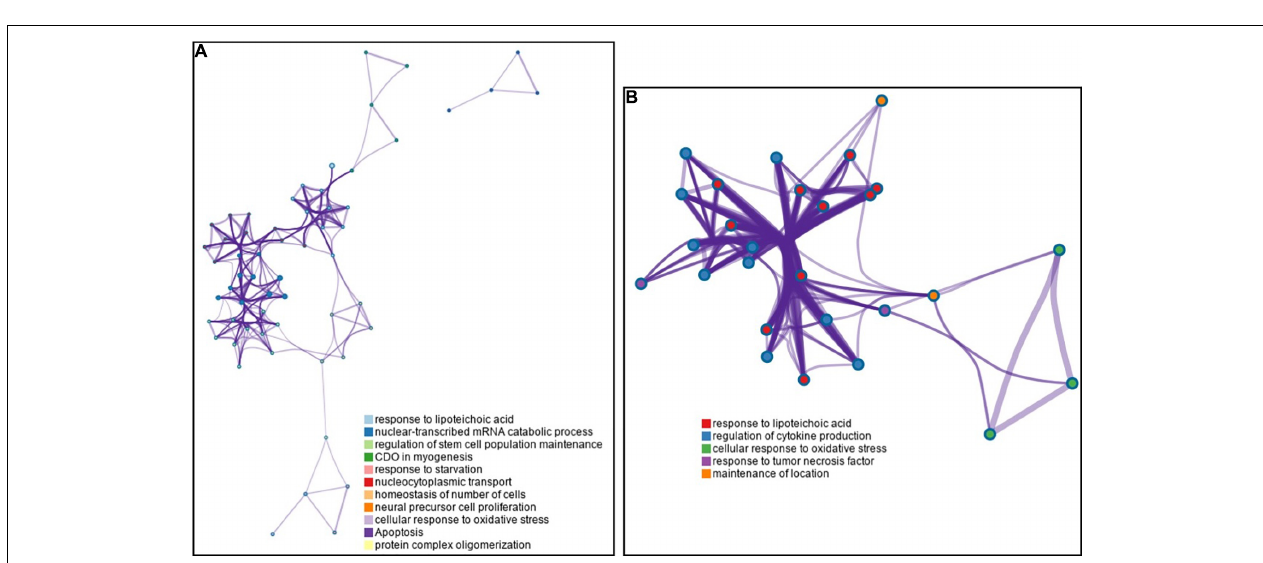
FIGURE 4 | Functional enrichment analyses of differentially expressed genes at the mRNA level analyzed by Metascape pathway. (A) Association between the top 11 clusters and (B) 5 clusters of enriched terms displayed as a network enrichment analysis of 55 intersected and of 10 selected differentially expressed mRNAs, respectively. Nodes of the same color belong to the same cluster. Terms with a similarity score > 0.3 are linked by an edge. The network was visualized with Cytoscape with force-directed layout and edge bundled for clarity. The analysis was conducted using the web-based bioinformatics tool DAVID (omicX, Seine Innopolis, Le-Petit-Quevilly,